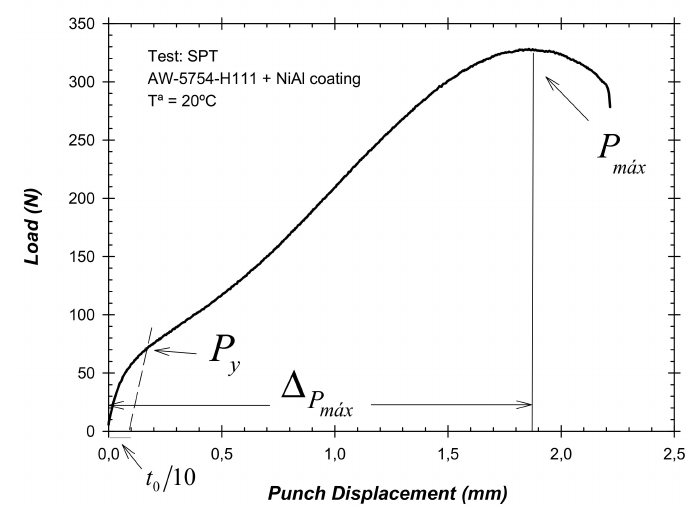
Figure 2. Typical load–displacement curve for the Small Punch